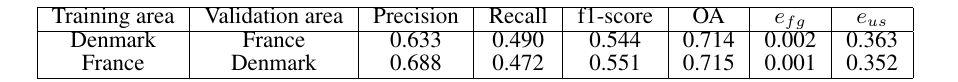
Table 2. Prediction accuracy assessment of Mask R-CNN for one geography when the model is trained with data from another